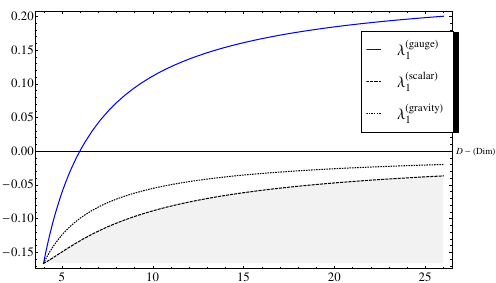
Figure 1 . Case (ii) of the sections 2.1.1 and 2.2.1 | the blue solid line gives the values of (cid:21) 1 ( D ) which allow the localization of the ^ A (cid:22) (cid:12)eld. The region below the dashed line shows the values which allow the localization of the B j (cid:12)elds. Also, the region below the dotted line are the values of (cid:21) 1 ( D ) for which the localization of gravity ensures the localization of ^ A (cid:22) .